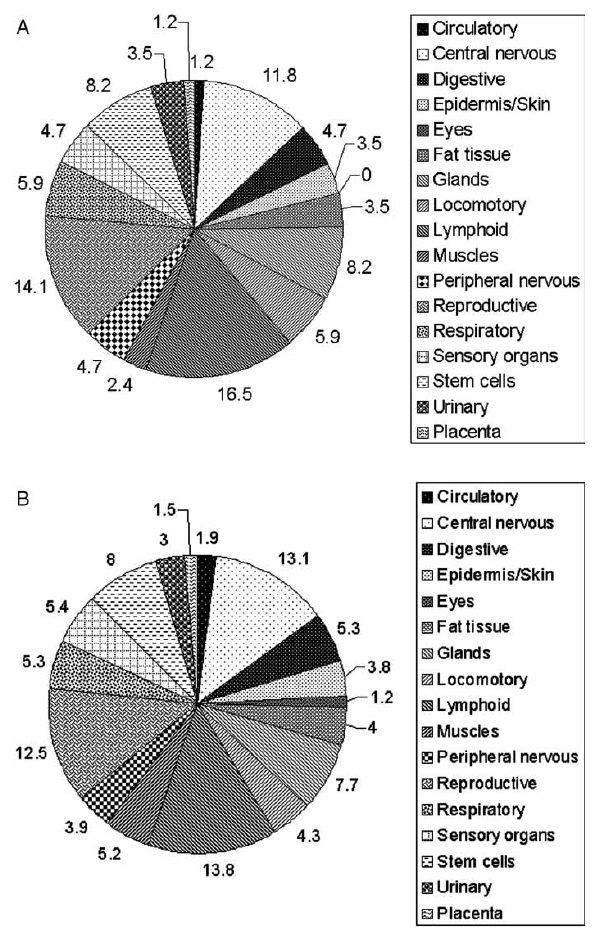
Figure 2. Representation of tissue/organ systems specific gene expression in the fetal thymus during the emergence of TRBV8.1 recombination. Analysis of 4500 sequences was performed using glass slide cDNA microarrays, whose significant induced genes were annotated characterizing the promiscuous expression, which allow self-representation of tissue specific antigens in the thymus. 2A ¼ C57Bl/6, 2B ¼ (Balb-c £ C57Bl/6)F 1